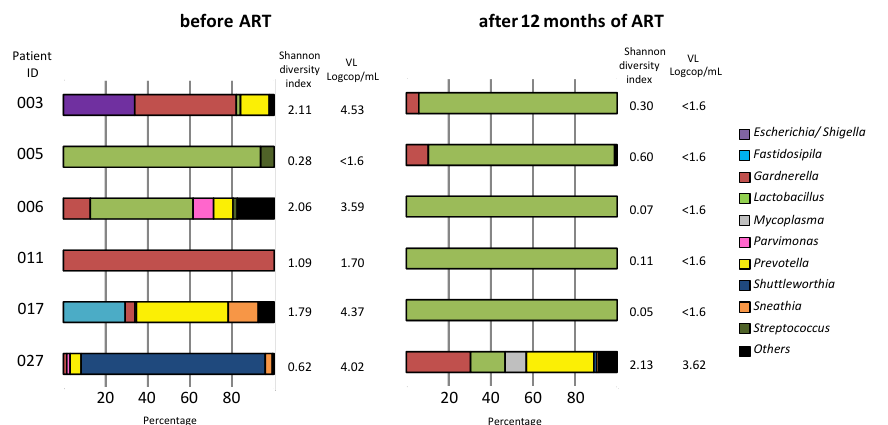
Figure 3. Cervicovaginal microbiota analysis in six patients according to HIV viral load in CVF, before and 12 months after ART initiation.